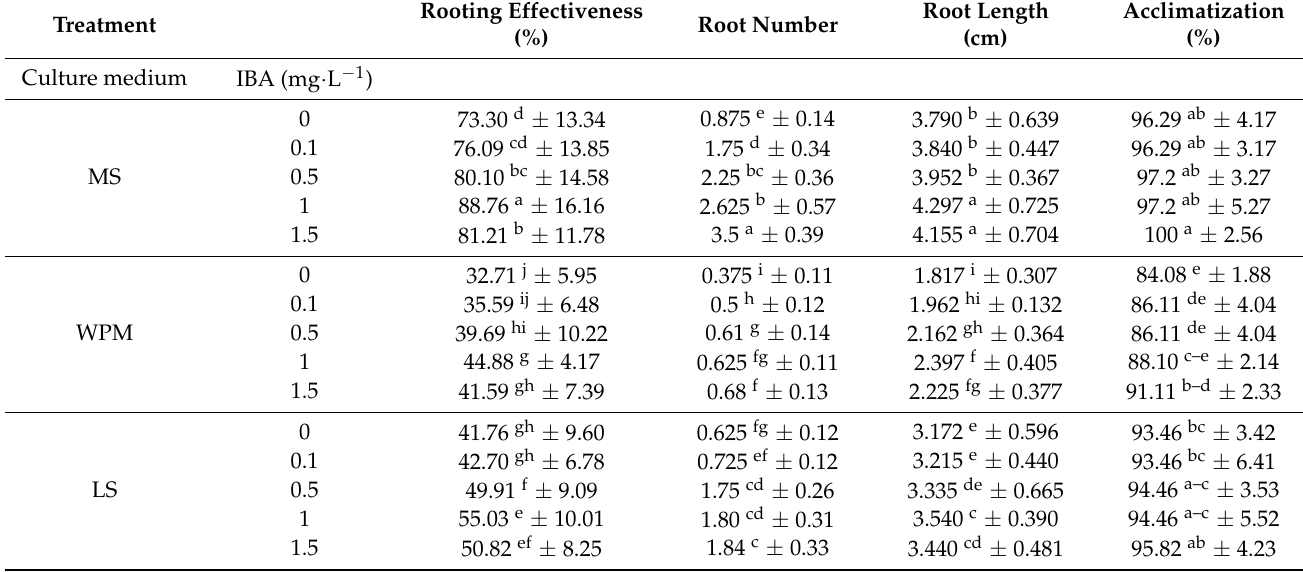
Table 4. Effects of the different concentrations of IBA and the basal culture medium type on the measured characteristics of the Pyracantha angustifolia plants grown in vitro in the rooting step, as well as the acclimatization